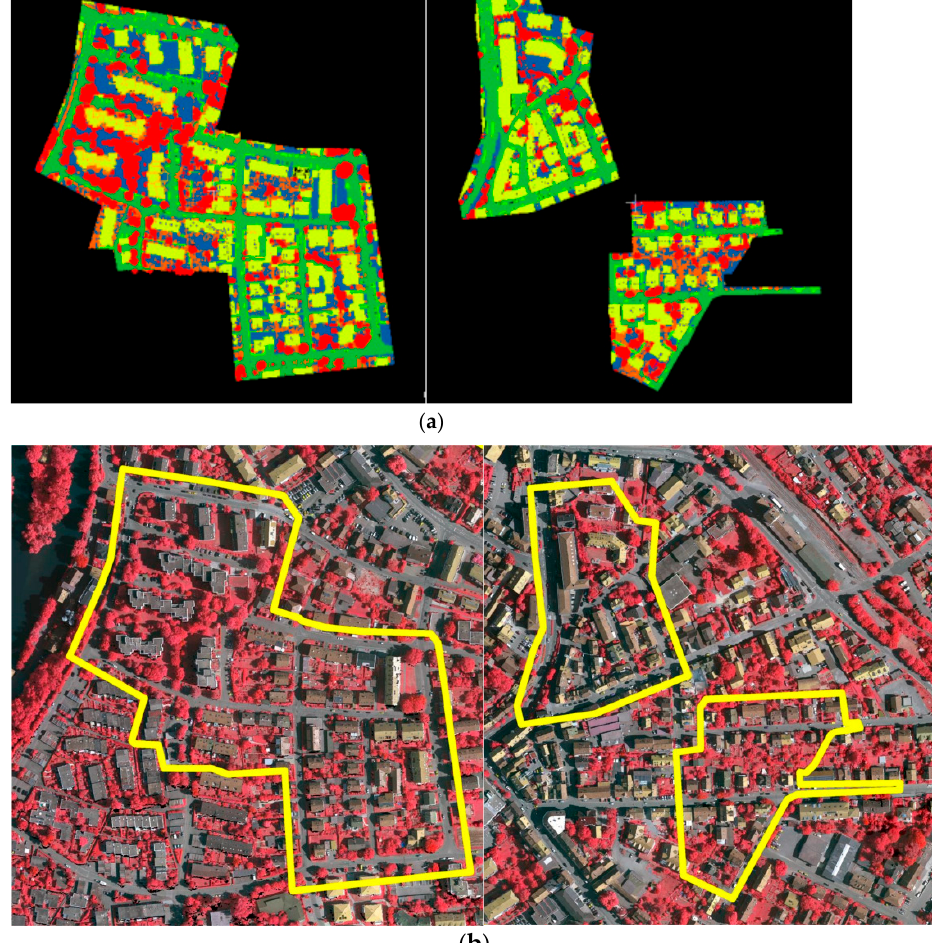
Figure 3. Point cloud color-coded ( a ) by categories for the train data and test data, and ( b ) by spectral information (IR, R, G) for the training area and the test area.